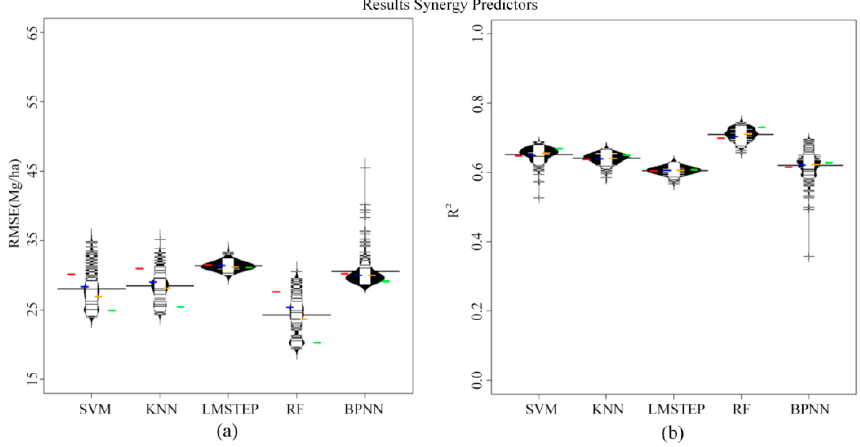
Figure 4. The beanplots illustrate the distribution of the mean RMSE ( a ); and R 2 ( b ) values from the 100 bootstrapped models based on the combined optical and microwave optimal variables in Experiment 2 (iii). Explanations follow those from Figure3.